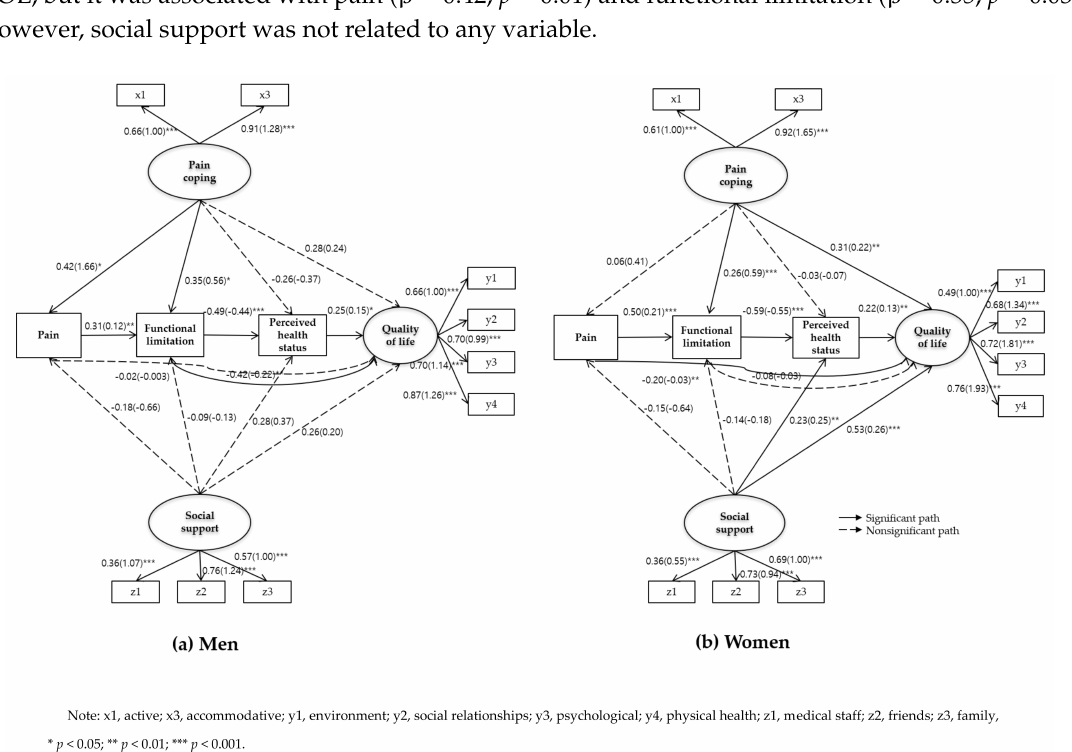
Figure 2. The estimated paths in ( a ) men and ( b )